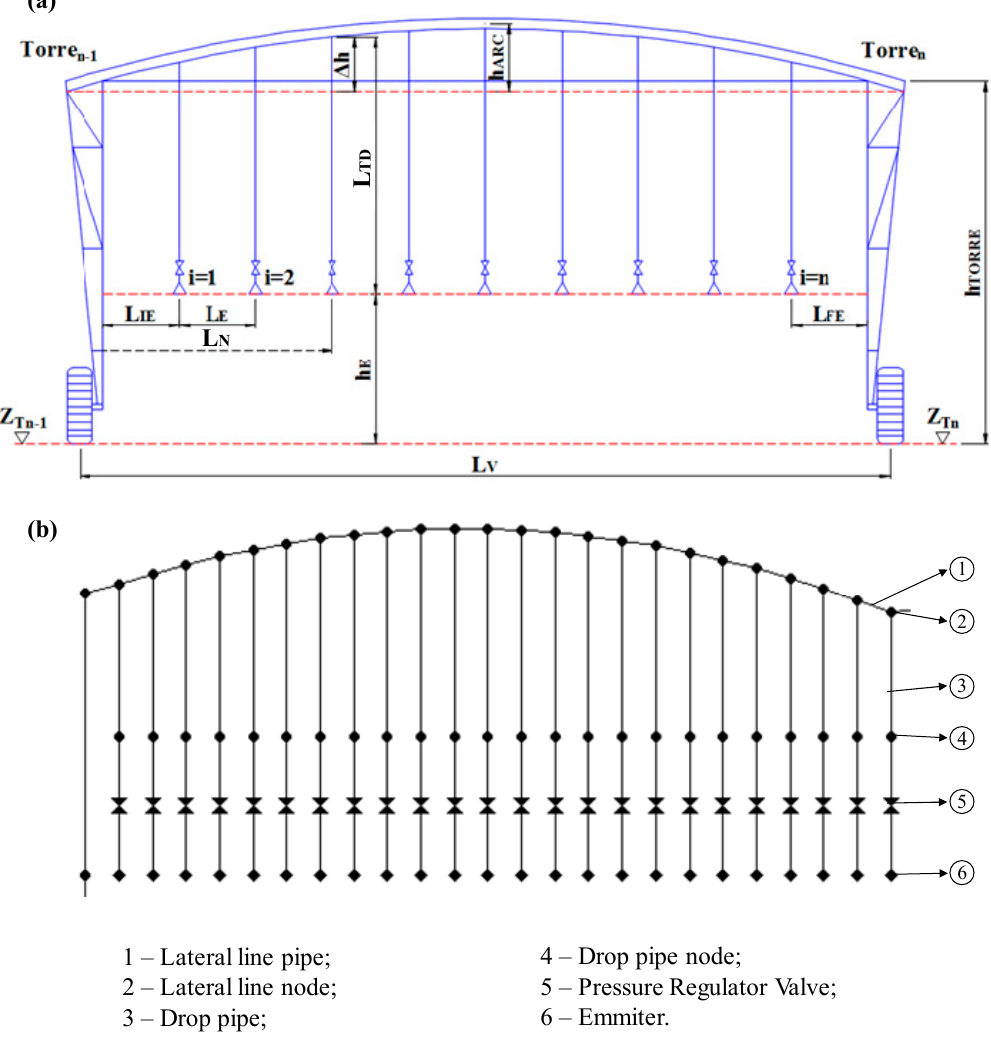
Figure 3. ( a ) Center pivot lateral line span dimensions, ( b ) EPANET network map of the first span of the center pivot lateral line.